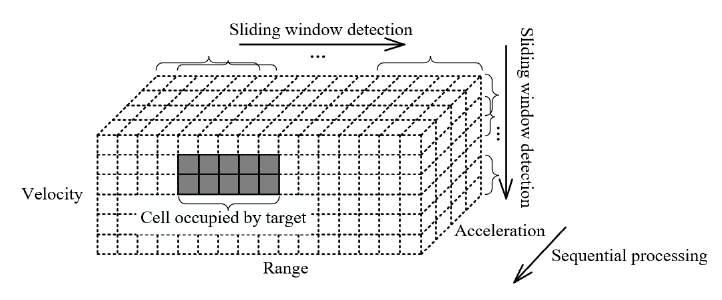
Figure 9. Two-dimensional sliding window detection in the three-dimensional parameter space of